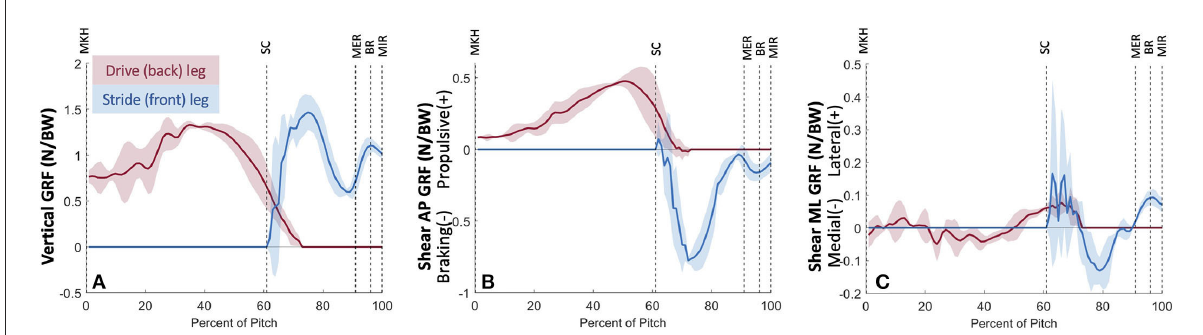
the pitch and the stride leg producing peak vertical GRF of 1.47 ± 0.18 N/BW at 75% of the pitch (Figure 3). Anterior–posterior (AP) shear force in the direction of pitch (Figure 3) indicates that the drive leg creates a 0.48 ± 0.03 N/BW propulsive force peaking before SC at 50% of the pitch. Following SC, the stride leg creates a braking force with a peak magnitude of 0.77 ± 0.02 N/BW at 72% of the pitch. There is little mediolateral (ML) shear